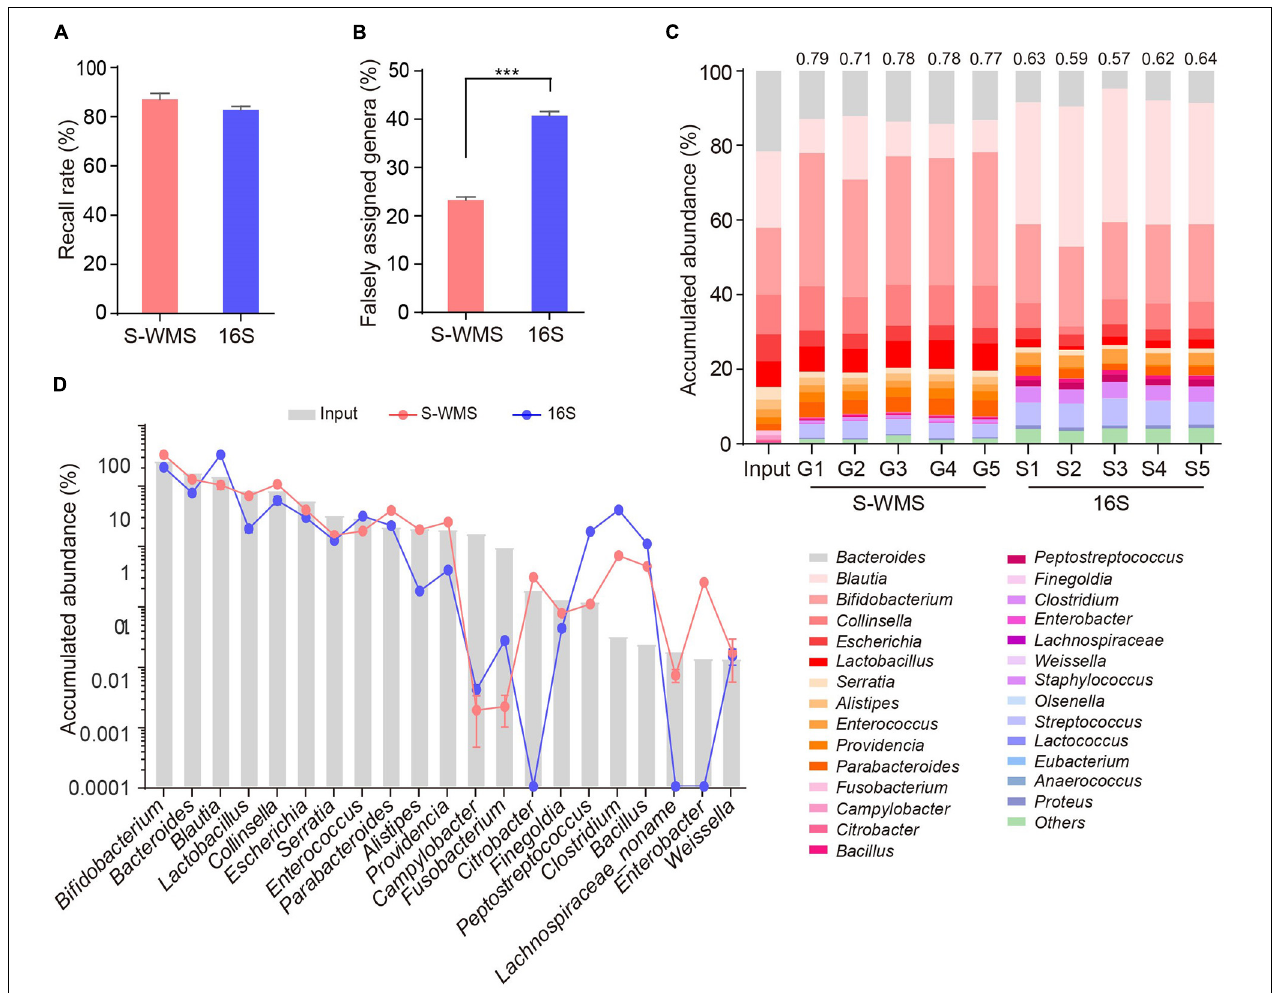
FIGURE 3 | Genus composition of a high-complexity artificial microbial community (MOCK2) assessed by shallow WMS or 16S. (A) Genus recall rate. (B) Falsely assigned genus rate by 16S or S-WMS. (C) Stacked bar plot of genera abundances. The values on top of the bar graph indicate the Spearman correlation coefficient between S-WMS/16S data and the actual (Input) values. (D) The relative abundance of dominant genera determined by 16S or S-WMS. The gray bars indicate the actual (Input) value. Sixty-three gut bacterial species (belonging to 28 genera) were cultured under standard laboratory conditions. The artificial community was sequenced five times by each approach. *** p <